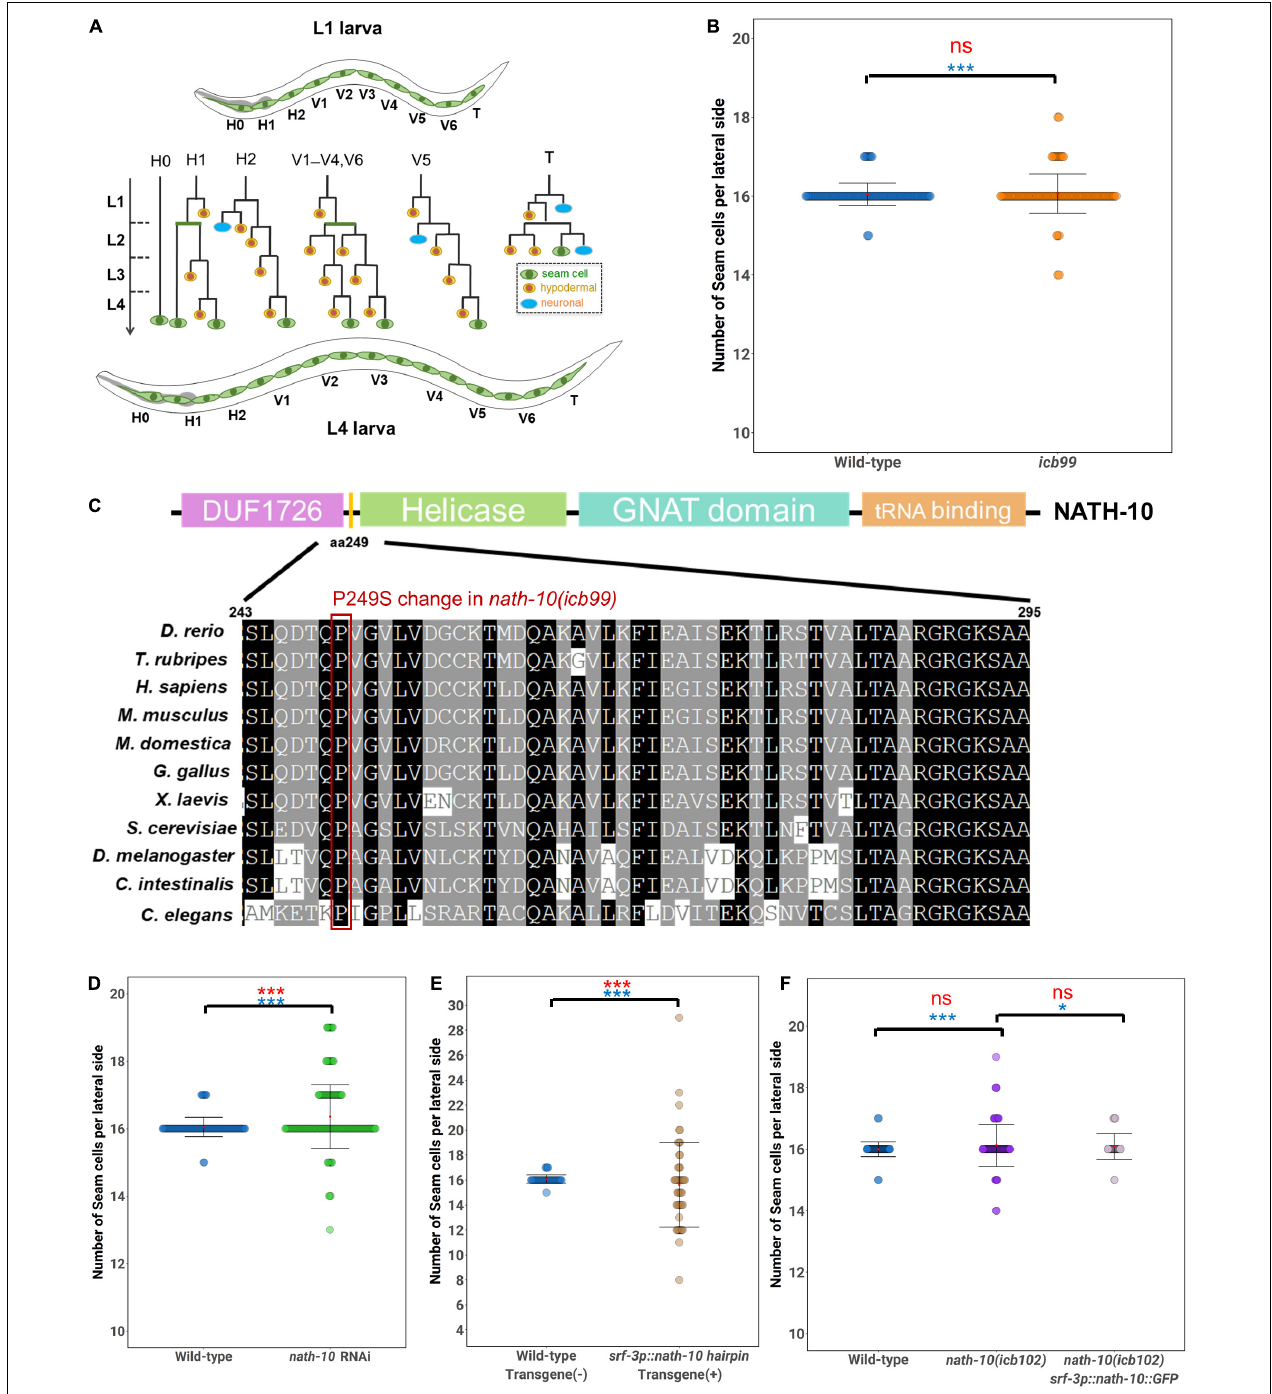
FIGURE 1 | Seam cell number robustness is disrupted by nath-10 loss-of-function. (A) schematic displaying seam cell lineage from L1 to L4, seam cells are labeled green, hypodermal cells are labeled yellow and neurons are labeled blue. (B) Mutants carrying the icb99 mutation display variable seam cell number ( SD = 0.28, n = 120 for wild type JR667 animals, SD = 0.50, n = 120 for animals carrying the icb99 mutations. Red ns indicates non-significant difference to the mean by t -test ( p > 0.05). Blue stars indicate statistically significant difference to the variance by Levene’s median test (*** p < 0.001). (C) Schematic showing protein domains in NATH-10. The P249S change involves a proline to serine shift at amino acid 249, indicated by the yellow bar between the DUF1726 and Helicase domains. Alignment of this region across multiple species shows high conservation of this proline, suggesting it may be of importance to protein function. Red frame shows the conserved proline. (D) nath-10 RNAi phenocopies the icb99 mutation leading to a significant increase in variance and average seam cell number (Levene’s